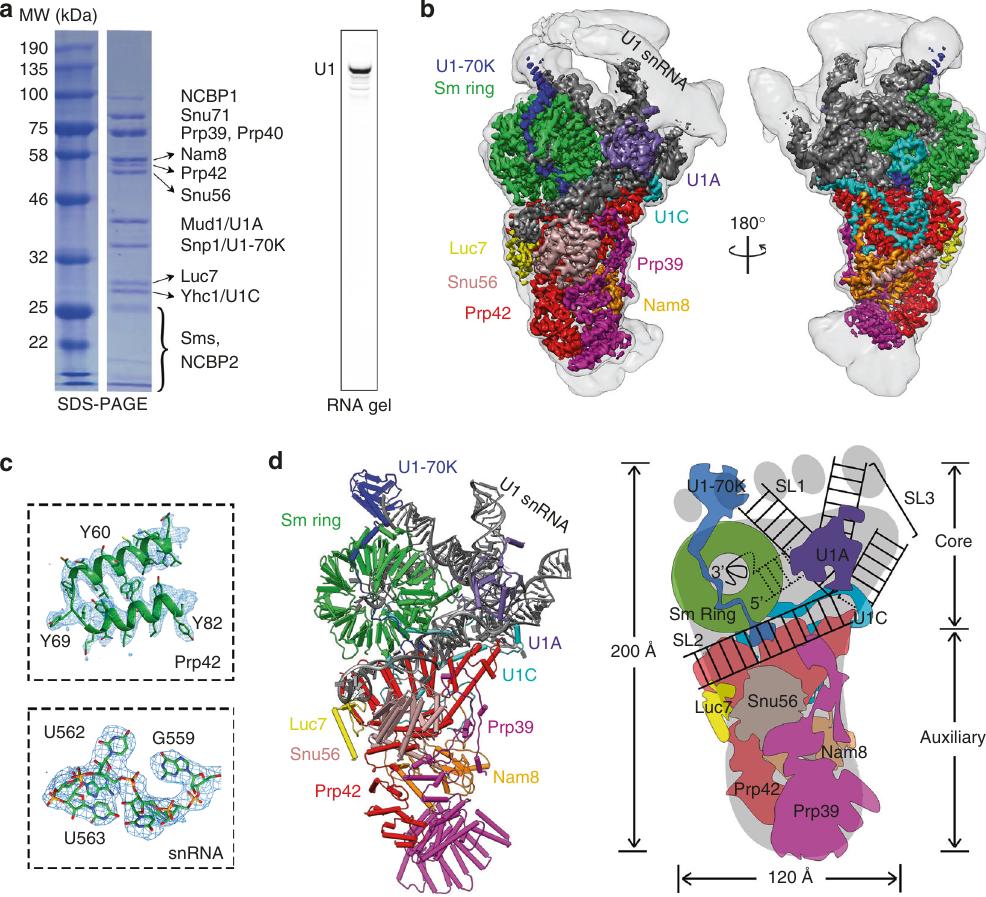
Fig. 1 Overall cryoEM structure of the yeast U1 snRNP. a Puri fi ed yeast U1 snRNP sample used for cryoEM structure determination was analyzed on SDS- PAGE and its protein components identi fi ed using mass spectrometry analyses. The sample was also analyzed using solution hybridization 48 to demonstrate the presence of U1 snRNA in the sample. b Surface representation of the cryoEM map of yeast U1 snRNP. The density map (3.6 Å resolution) for each component is shown in different colors. The EM map is low-pass fi ltered to 8 Å resolution to show more fl exible regions of the U1snRNP (transparent gray). c Examples of the 3.6 Å cryoEM density with atomic models built in. d Model of the yeast U1 snRNP with each protein in a different color. A schematic representation of the structure is also shown using the analogy of a foot. All fi gures in the paper are prepared using Chimera